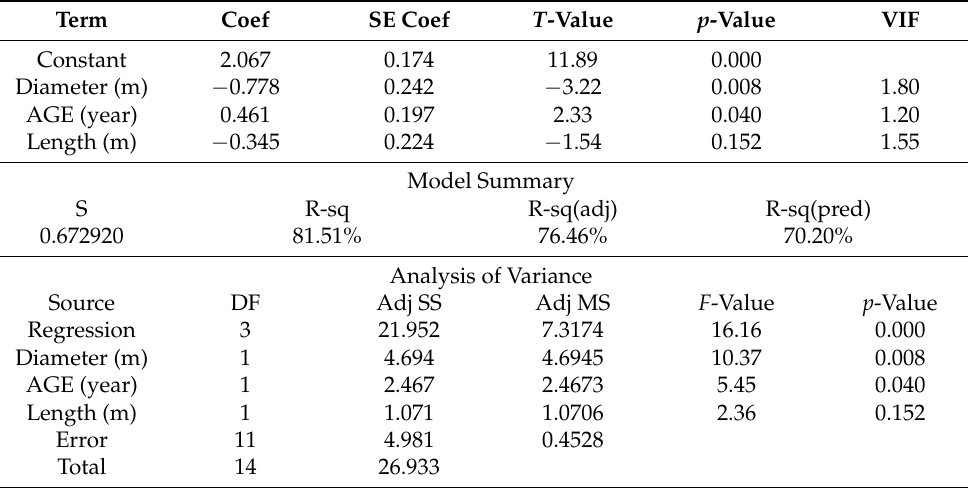
Table 4. Regression Analysis of Ductile iron sewer pipe.